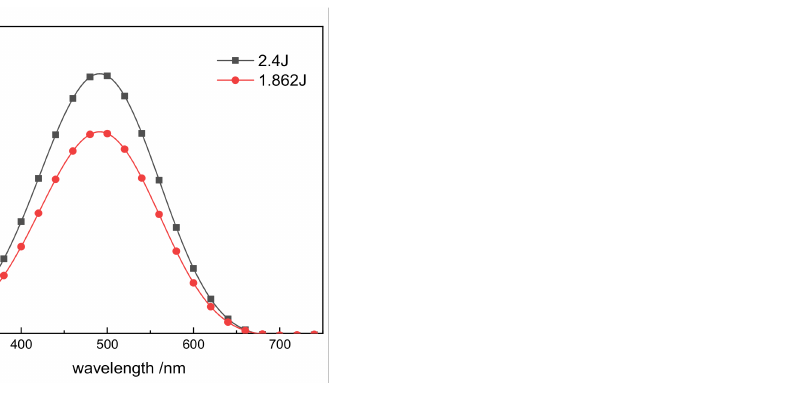
Figure 4. Thomson scattering spectrum generated by the laser when the coating was intact ver- sus damaged.